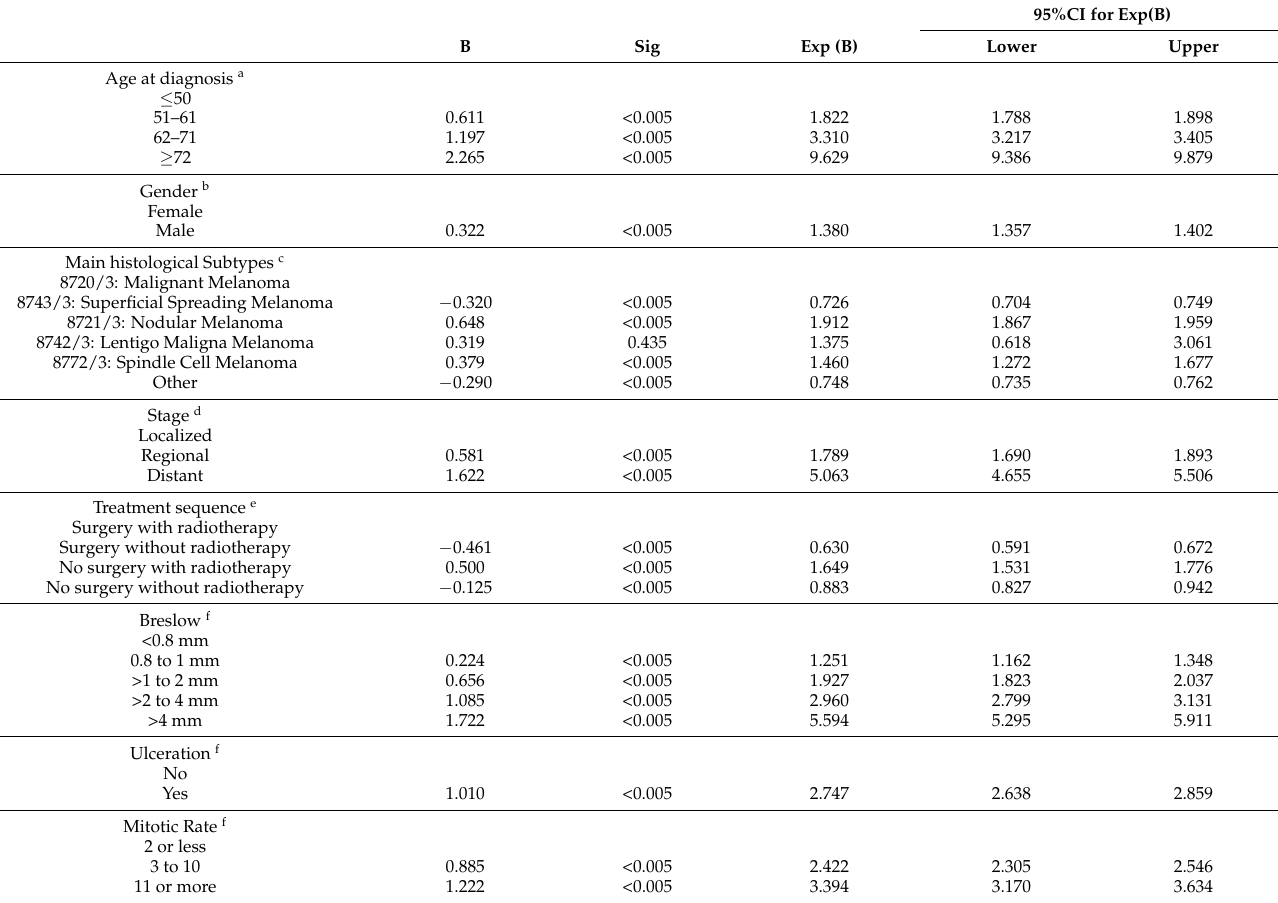
Table 3. Multivariate